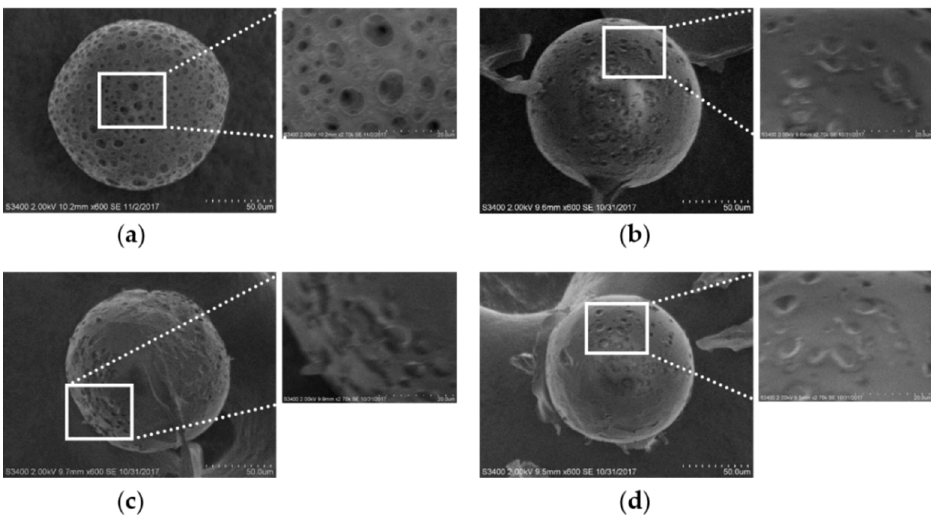
Figure 3. Surface morphology of ( a ) PLGA MS without calcium alginate coating (F6) and the MS with pores closed using sodium alginate solutions of different concentrations of ( b ) 1% (F7), ( c ) 1.5% (F8), and ( d ) 2% (F9) observed by scanning electron microscopy. PLGA, poly(lactide- co -glycolide); MS, microspheres.